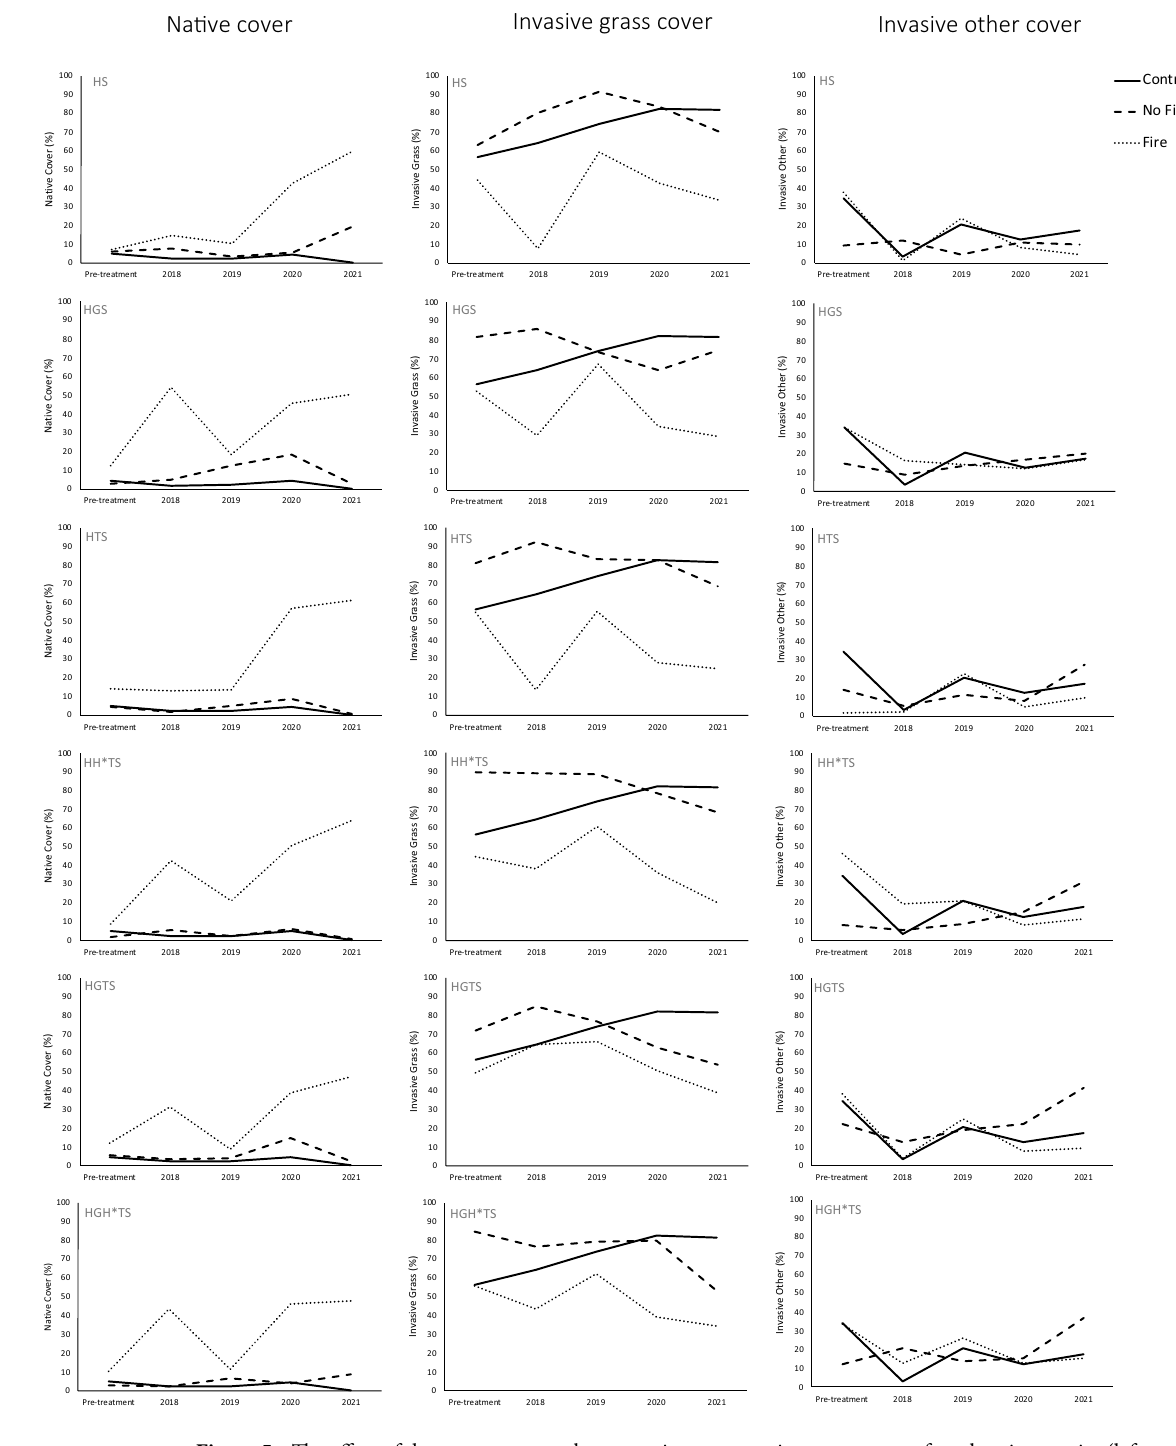
Figure 5. The effect of the treatments on the vegetation community mean cover of total native species (left column), total invasive grasses (centre column) and total invasive herbs, forbs and woody species (right column). Each row represents a different treatment, and the treatment code is listed beside each row (refer to Table 2). The control (NT) treatments are represented by the solid line, the unburnt treatments are represented by the dotted line, and the fire treatments are represented by the dashed